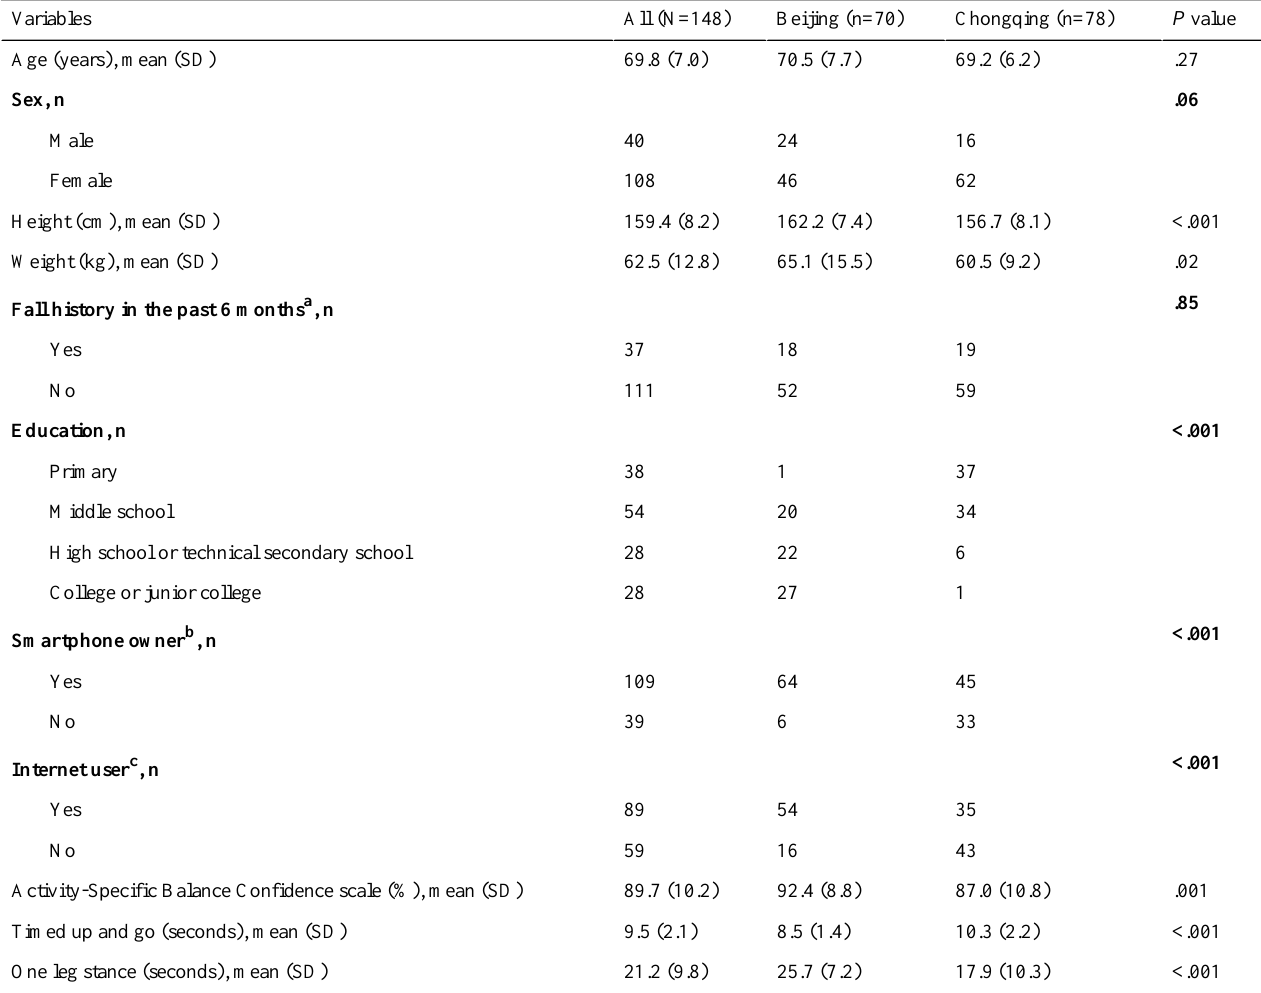
Table 1. Demographics and functional performance of participants in this study